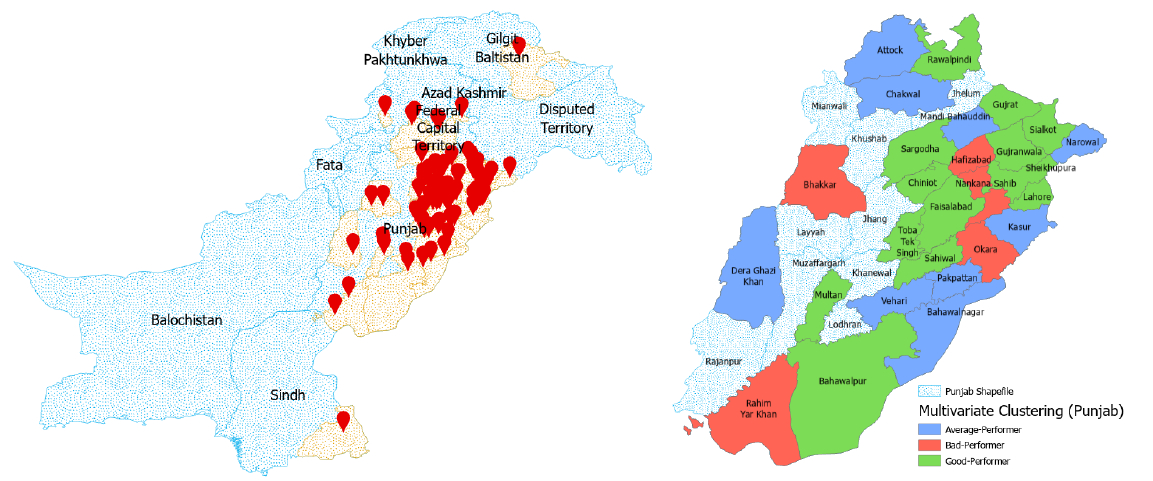
Figure 5. Multivariate clustering of students data (Pakistan and Punjab